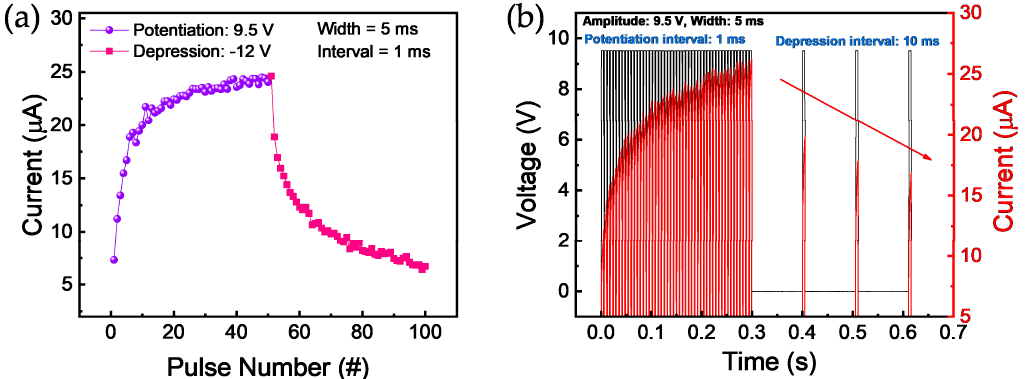
Figure 5. Potentiation and depression characteristics of the Pt / HfO 2 / TaO x / TiN device. ( a ) Current modulation controlled by set and reset pulses; ( b ) natural depression process that involves increasing the interval time between pulses.